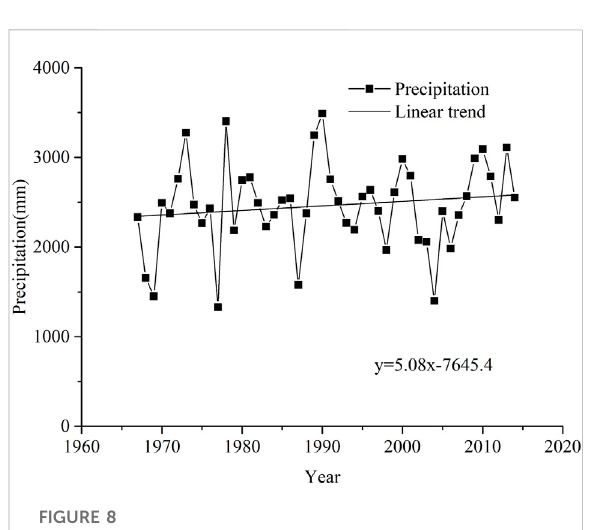
FIGURE 10 The process of annual evaporation changes in the Wanquan River